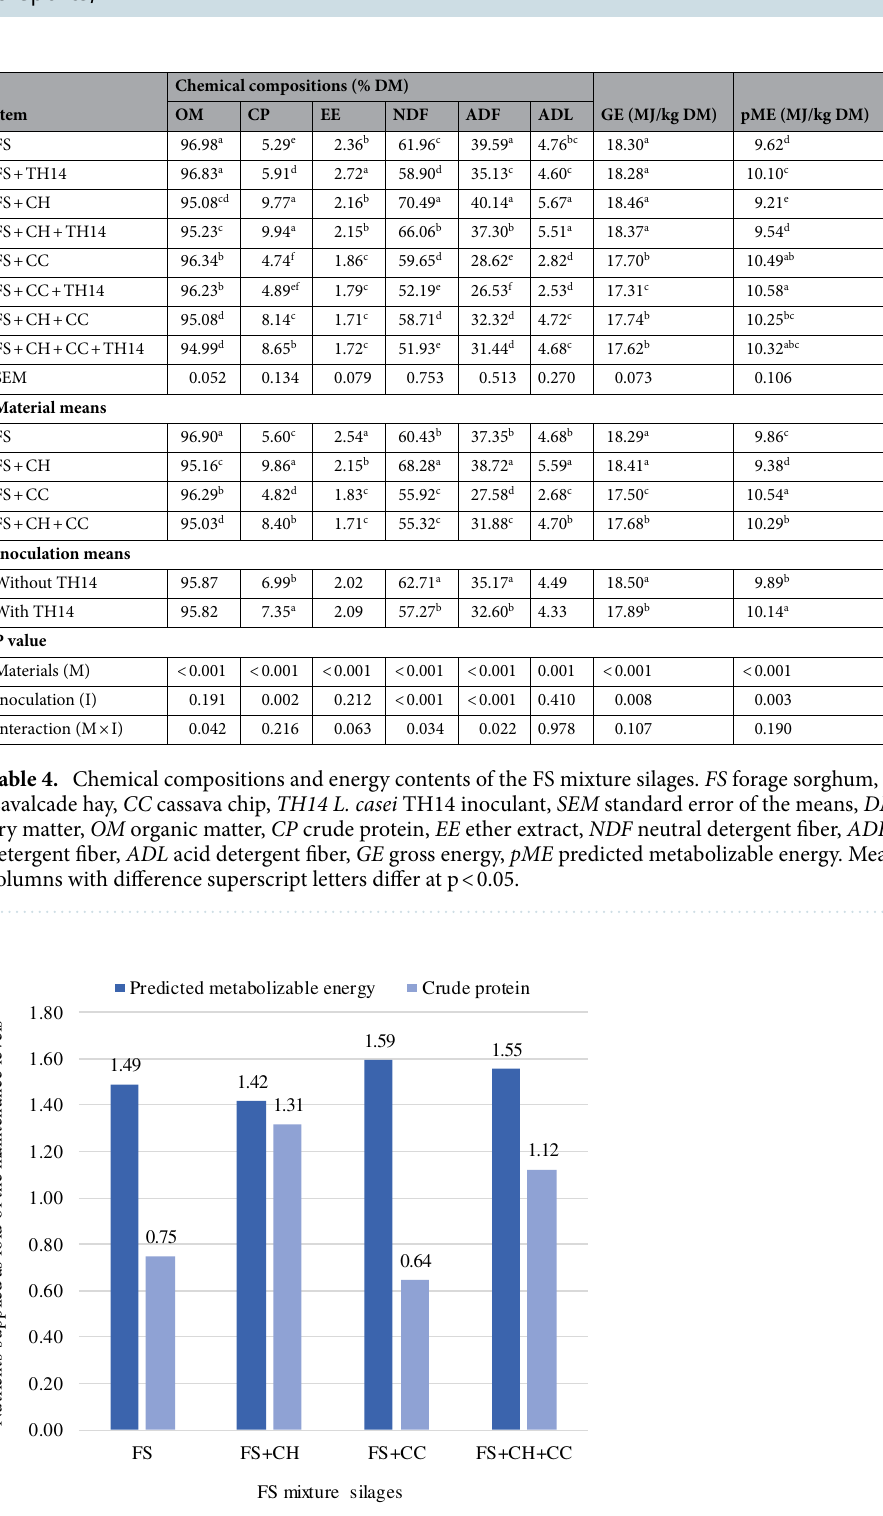
FS, and FS + CH silages (Table 5). The in vitro OM digestibility (IVOMD) was the highest (p < 0.05) in FS + CC silage, followed by FS + CH + CC, FS, and FS + CH silages. The total gas production and CH 4 production (L/ kg DM and % GE) were the highest (p < 0.05) in FS + CC silage. Compared to control silage, the LAB-treated silage increased IVDMD and IVOMD with decreased (p < 0.05) total gas and CH 4 production. Interaction did not affect (p > 0.05) all parameters. When incubation was prolonged to 48 h, the effects of LAB inoculation were